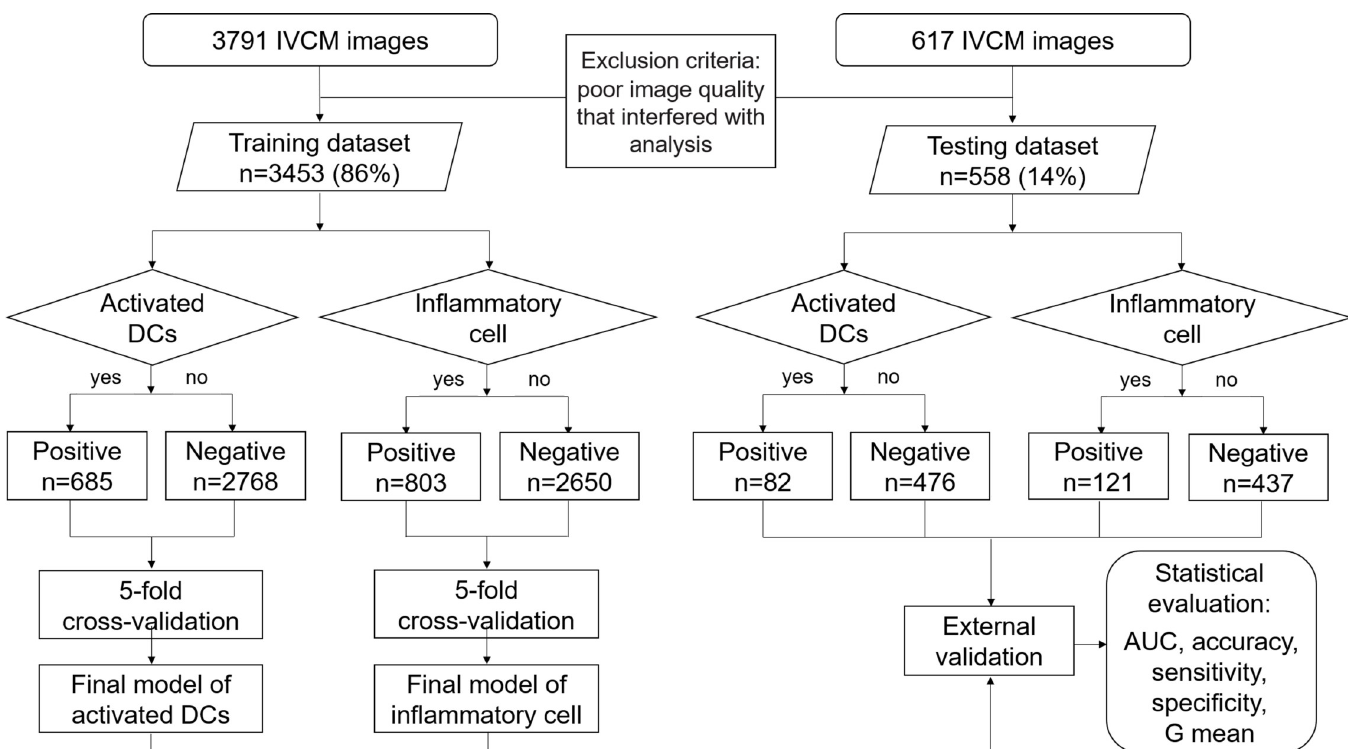
Fig 4. The detailed model building process. The training dataset consisted of 3453 (86%) in vivo confocal microscopy (IVCM) images. Five-fold cross-validation was used for parameters tuning. The testing dataset comprised 558 (14%) IVCM images and was used to perform external validation. Area under the curve (AUC), accuracy, sensitivity, specificity, and G mean were calculated to evaluate the final performance of the deep transfer learning models.